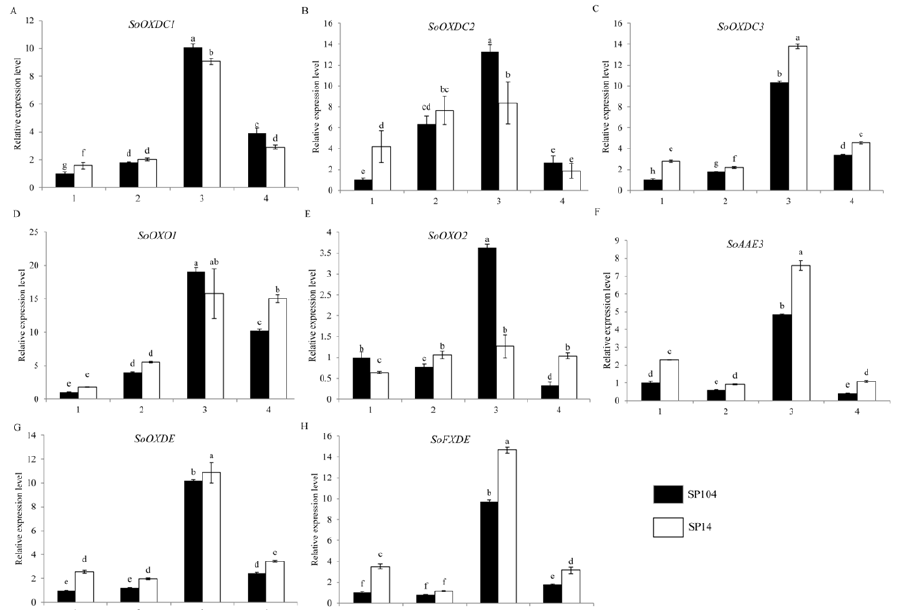
Figure 5. Expression profiles of putative genes involved in oxalate degradation pathways in spinach. The four parts were as follows: (1) mature leaf laminas; (2) mature leaf petioles; (3) young leaf laminas; (4), young leaf petioles. Error bars represent standard deviation among three real-time quantitative PCR reaction replicates. Data are means of three replicates ±SD. Different lowercase letters indicate significant differences at P <0.05.